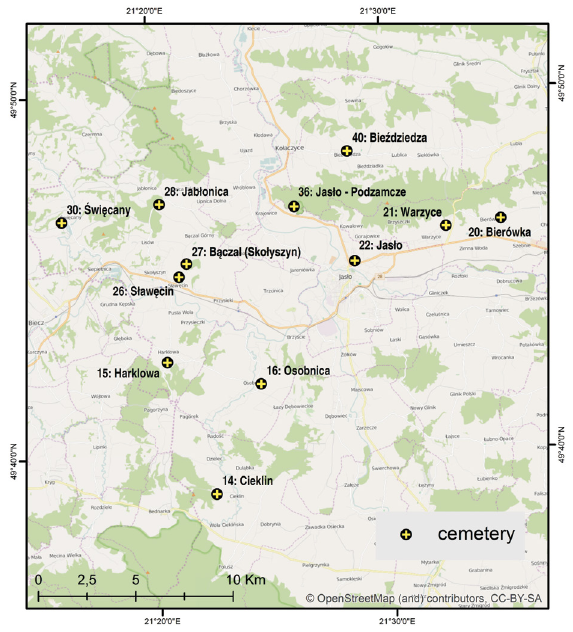
Fig. 1. Location of the analysed cemeteries